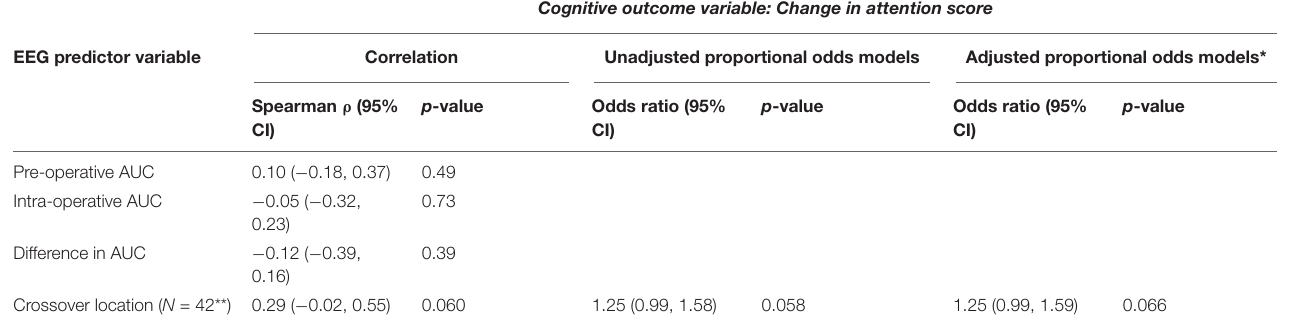
TABLE 3 | Association between EEG predictor variables and cognitive score changes from baseline to post-operative day 1. Cognitive outcome variable: Change in attention